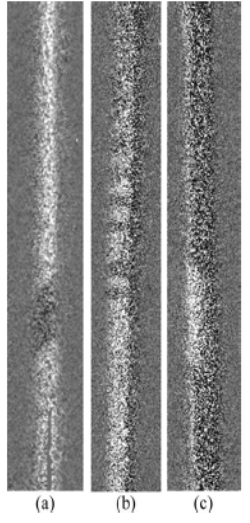
Figure 6. Co-rich microwire. Torsion-stress-induced transformation of surface domain structure ( a ) − 21 π rad·m − 1 ; ( b ) 5 π rad·m − 1 ; ( c ) +21 π rad·m − 1 . Reprinted with permission from [92].